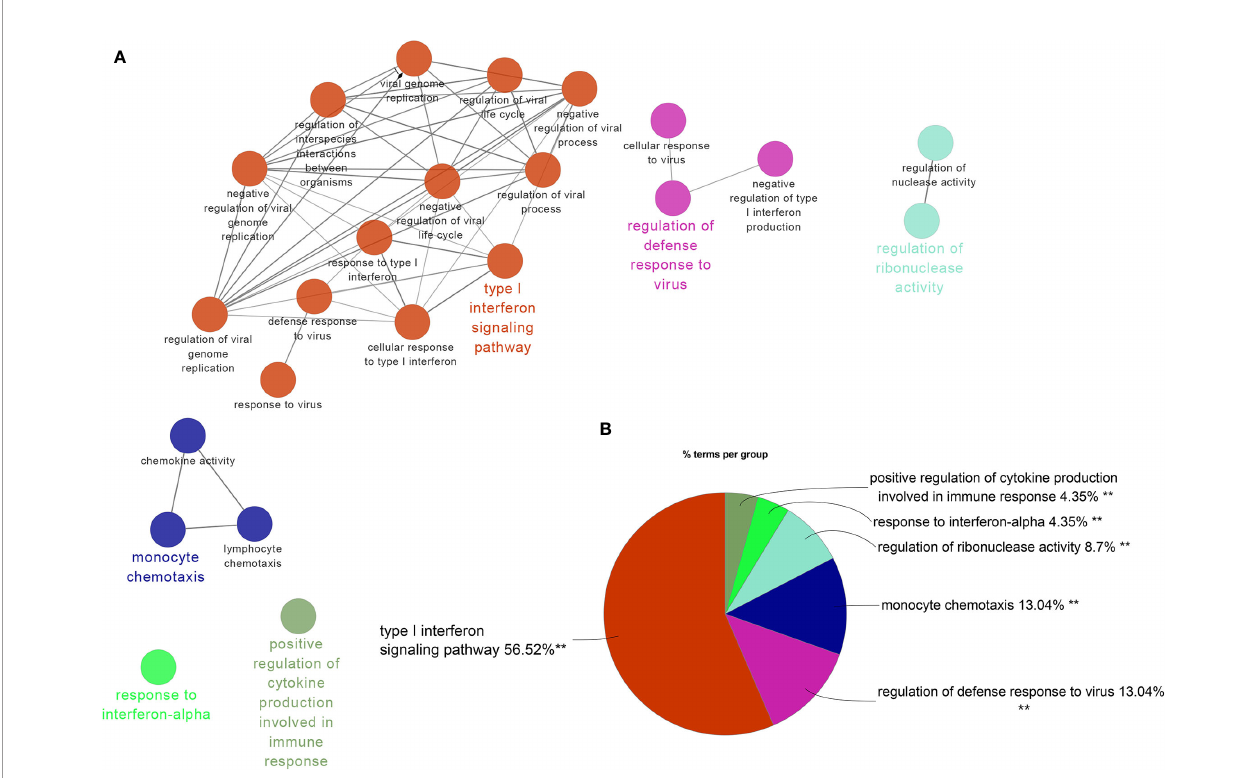
FIGURE 3 | ClueGO enrichment analysis. (A) The interaction network of GO terms generated by the Cytoscape plug-in ClueGO. The signi fi cant term of each group is highlighted. (B) Proportion of each GO terms group in the total. GO, gene ontology. ** p <